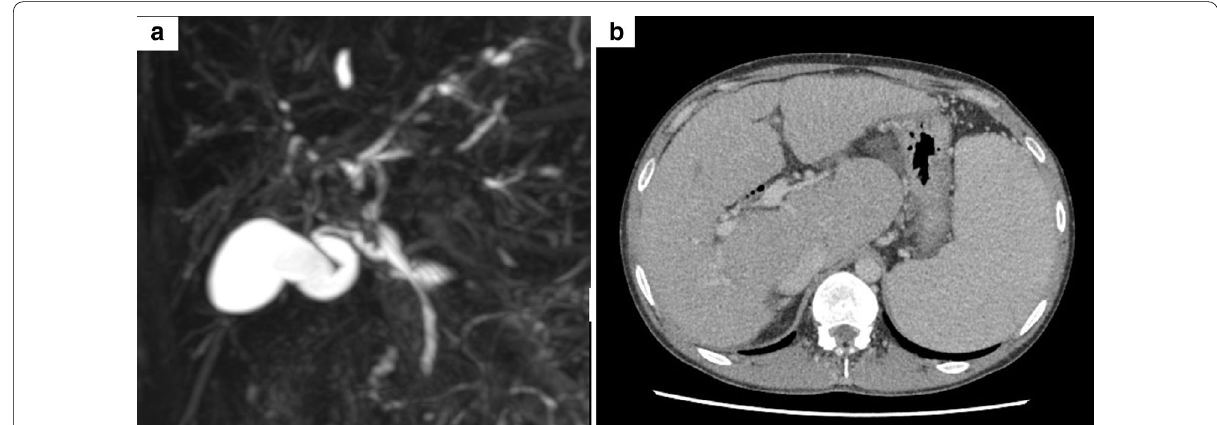
Fig. 1 The imaging findings of primary sclerosing cholangitis (PSC) are shown. a Magnetic resonance cholangiopancreatography revealed typical features of PSC with irregular narrowing of bile ducts, stenoses, and focal dilatation of bile ducts. b Computed tomography revealed a cirrhotic liver with an enlarged caudate lobe and splenomegaly